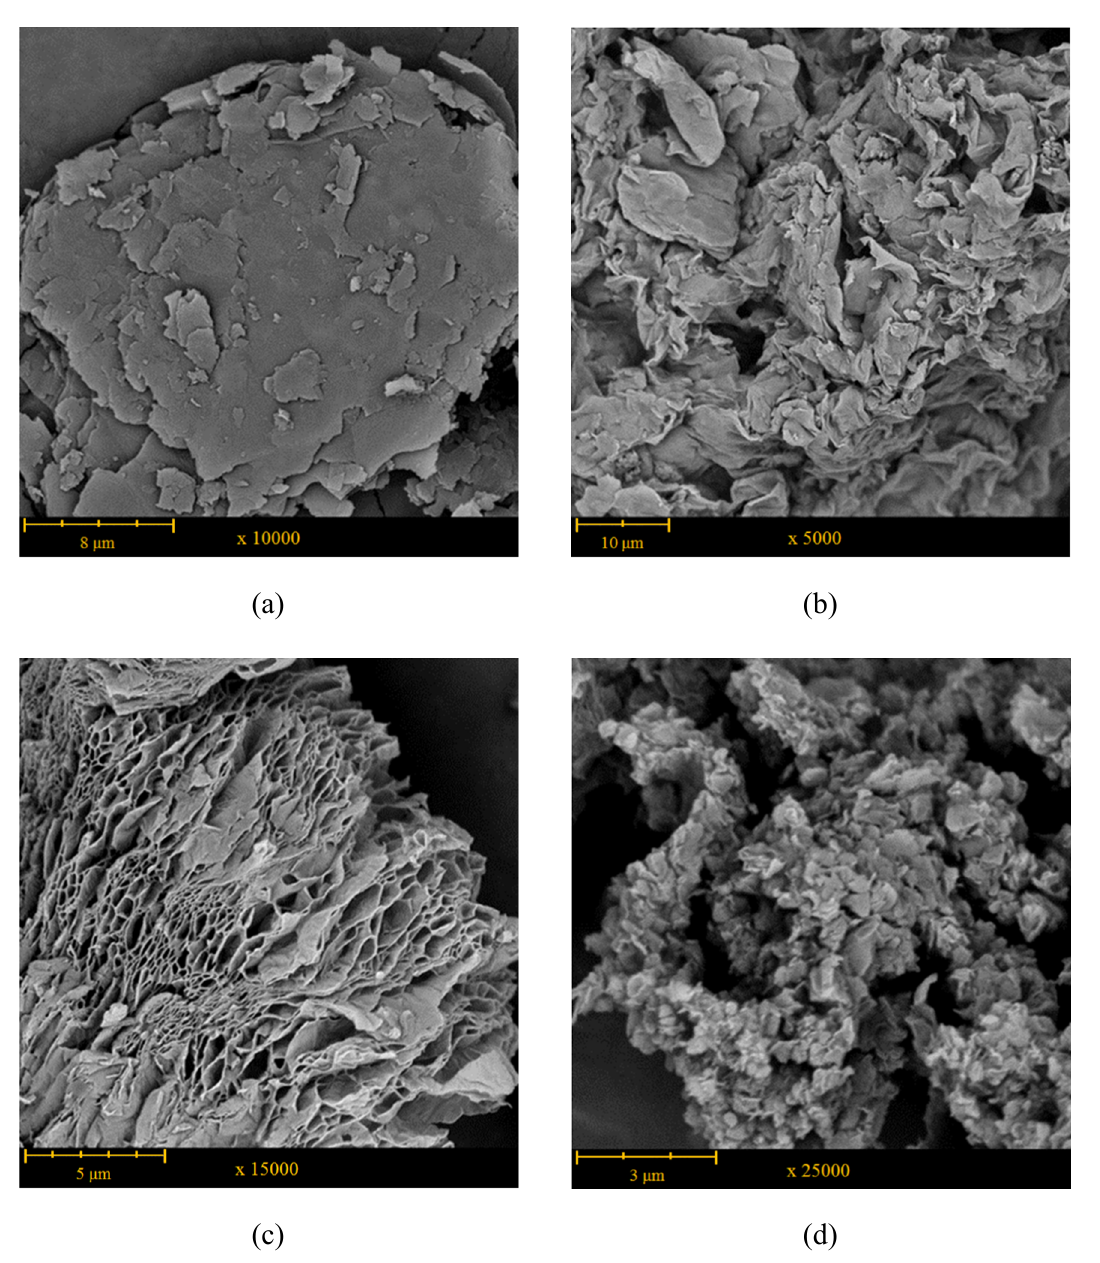
Figure 2. SEM micrographs of: ( a ) graphite; ( b ) graphene oxide (GO); ( c ) reduced graphene oxide (rGO); ( d ) functionalized reduced graphene oxide (rGO-CP).